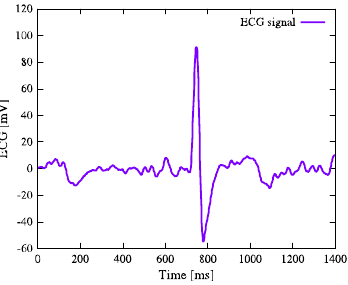
Figure 3: ECG acquisition and transmission in a moving car.